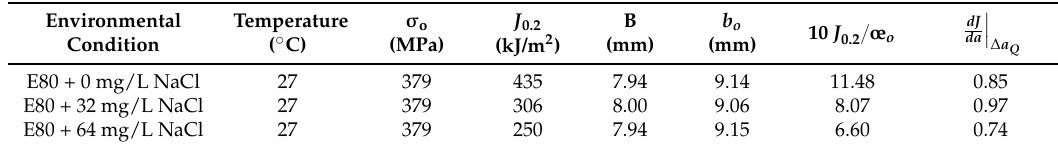
ˇ ˇ ˇ : tearing slope at critical crack da ∆ a Q